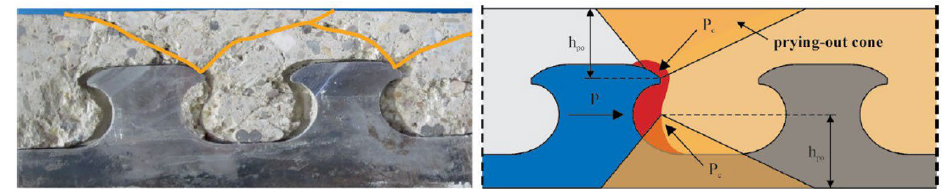
Figure 3. Concrete pry-out failure in MCL shear connectors – Feldmann et al. [2].